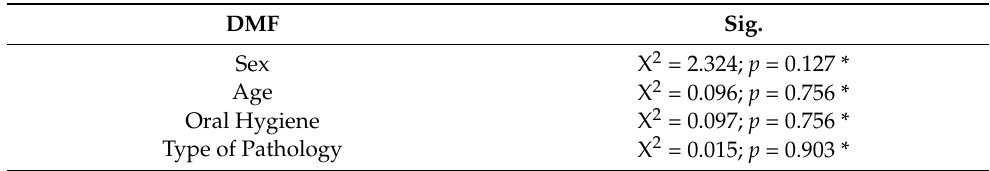
Table 6. Inferential analysis on the influence of sex, type of pathology, hygiene, and age in the Decayed, Missing, and Filled teeth index variations, between assessment moments. DMF Sig. Sex X 2 = 2.324; p = 0.127 * Age X 2 = 0.096; p = 0.756 * Oral Hygiene X 2 = 0.097; p = 0.756 * Type of Pathology X 2 = 0.015; p = 0.903